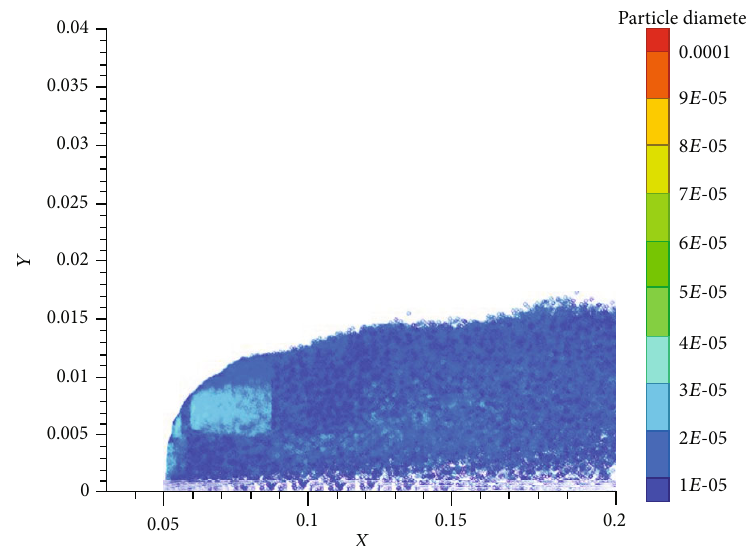
Figure 17: Spray penetration at t = 0 : 5 ms with low grid resolution.